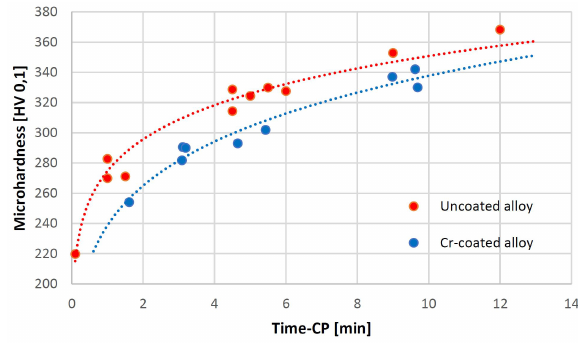
Figure 10. Comparison of differently rotated scratches.